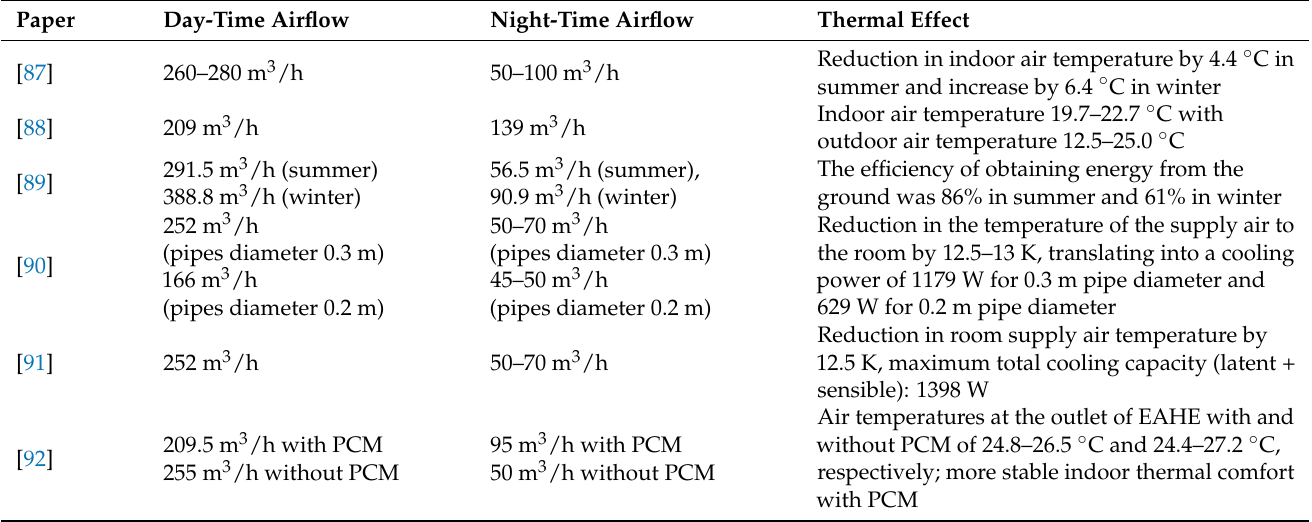
Table 4. A summary of SCEAHE research